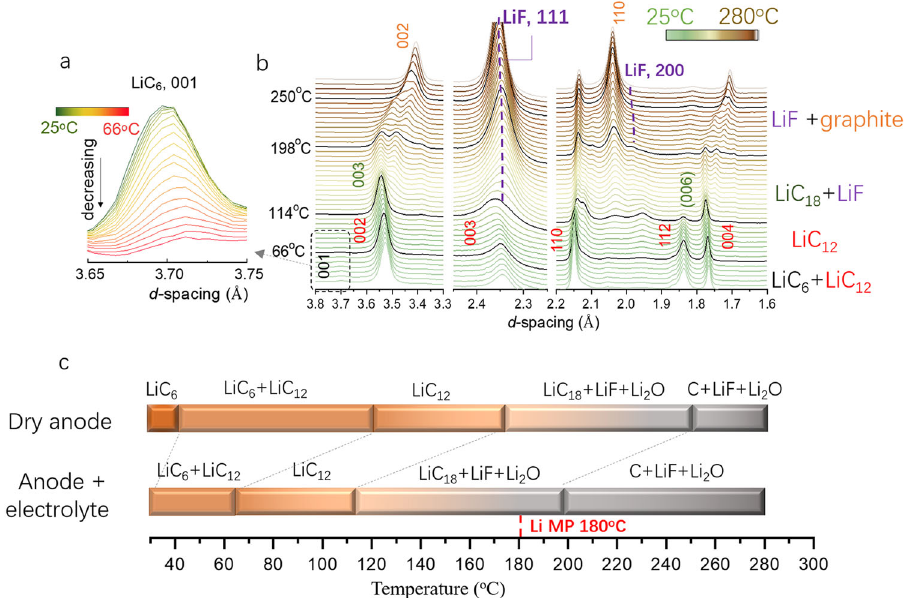
Fig. 6 The structural evolution of lithiated graphite with the electrolyte during heating. a The HEXRD plots of LiC 6 (001) Bragg re fl ection evolution from 25 to 66 °C. b The HEXRD plots of lithiated graphite anode with electrolyte from 25 to ~280 °C with 2 °C/min. The 2 θ value has been converted into d - spacing following Bragg ’ s rule. c The comparison of the phase evolution of the lithiated graphite anode with and without the presence of electrolyte. The lithium melting point (MP) 180 °C is also described in the fi Supplementary Fig. 18. The disappearance of LiC 18 (003) started the lithiated graphite decreased with the presence of electrolyte at 198 °C in comparison with 250 °C for the dry lithiated graphite (from ~220 °C with the dry lithiated graphite to 150 °C with the anode. With that, we can summarize the phase evolution pathway electrolyte 20,53 ). The accelerated decomposition of lithiated gra- phite with the presence of the electrolytes is because the large of the lithiated graphite anode during the heating process with amount of electrolyte salt (e.g., LiPF 6 ) that can be decomposed and without electrolyte, as in Fig. 6c. All phase transformations into highly reactive products, such as PF 5 (gas), OPF 3 , and HF occurred at a lower temperature with an ~60 °C decrease com- during heating 75 , and electrolyte solvents (e.g., EC) that can be pared to the dry lithiated graphite, implying a faster lithium reduced at high temperatures 76 , both of which can react simul- leaching kinetics by reacting with the electrolytes. This is well taneously with the metastable decomposition products in the SEI consistent with the literature reports by DSC heat generation layer or leached lithium, therefore, lower the onset reaction measurements, in which the heat generation onset temperature of